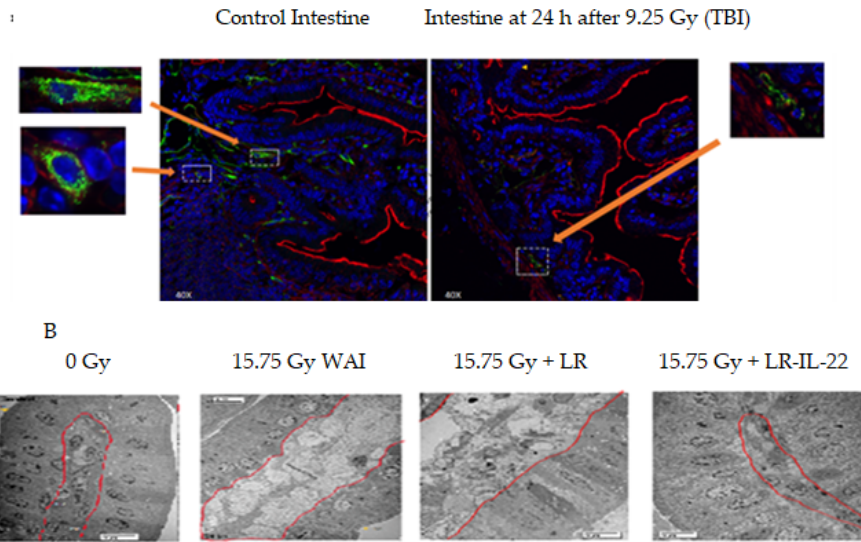
Figure 2. Effect of 9.25 Gy total body irradiation (TBI) or 15.75 Gy whole abdomien irradiation (WAI) observed as destruction of microvascular endothelial cells and cell swelling of the lamina propria including the intestinal multivasculature in the intestinal crypts. ( A ) Control mouse ileum and at 24